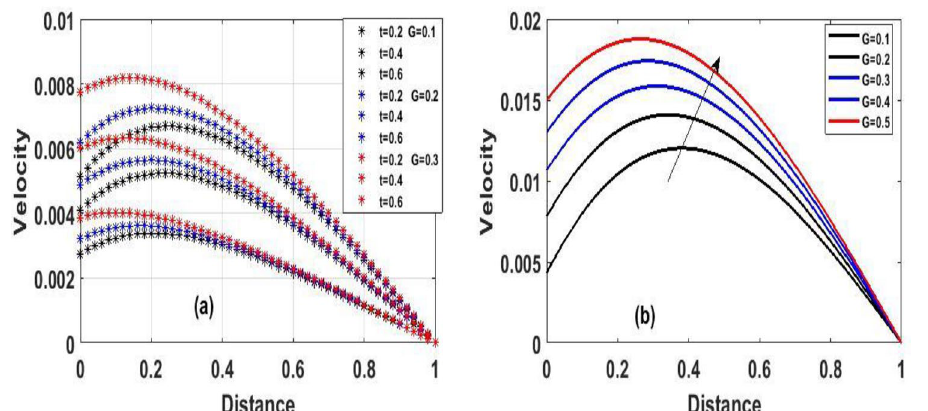
Figure 8. The effect of variation of γ for velocity steady and unsteady state.